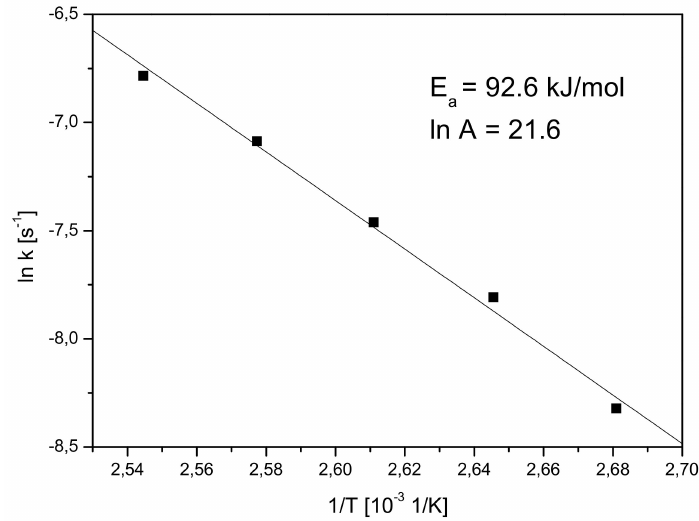
Figure 5. Arrhenius plot for the dehydration of fructose in 15 vol % water in HFIP, 22 g/L (23.8 mol %) Lewatit K2420 and 0.5 M fructose.